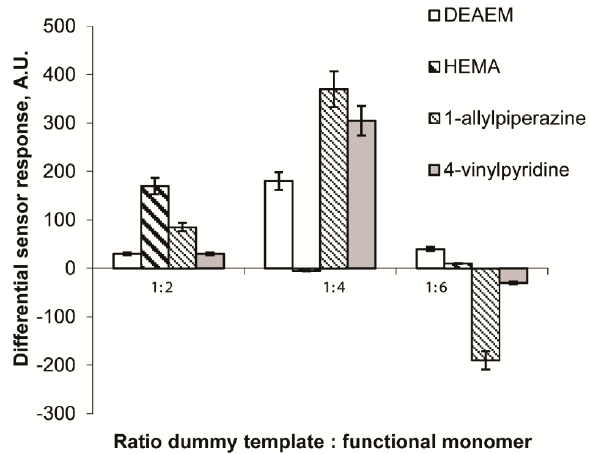
Figure 4. Influence of the chemical structure of the functional monomer used for the MIP synthesis and ratio CDHB:functional monomer in the polymeric membranes on values of the fluorescent sensor signals (aqueous working solution contained 25 µg mL − 1 zearalenone and 10% acetonitrile. Differential sensor response is a residual between sensor signals obtained by fluorescent sensors based on MIP and corresponding reference polymeric membranes.